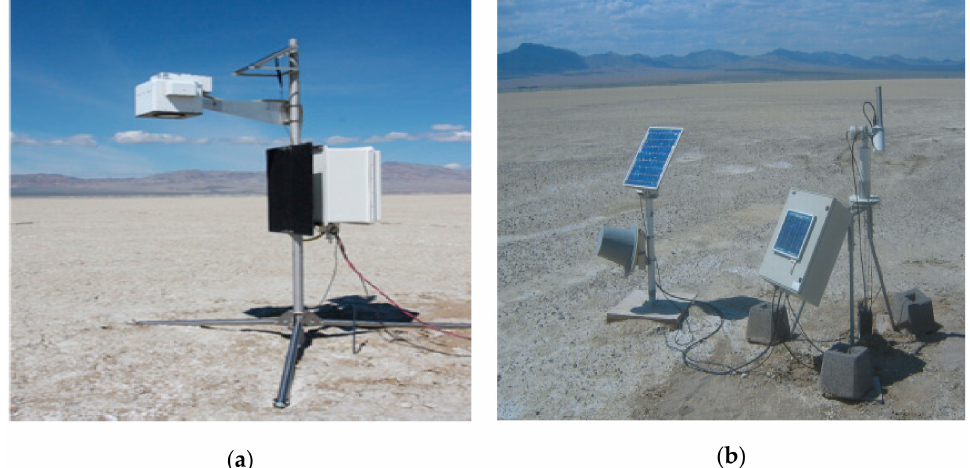
Figure 5. Automated ground instrumentation on site at Railroad Valley (RVUS): ( a ) ground-viewing radiometer, 1.5 m above the surface [13]. A solar panel (top) is used to charge the battery that powers the system; ( b ) Cimel sun photometer [22].